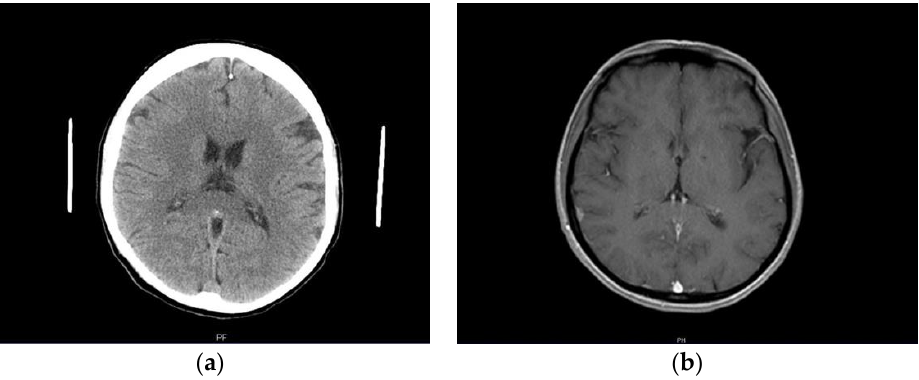
Figure 1. ( a ) Normal brain image — CT examination in native phase; ( b ) contrast-enhanced T1- weighted axial MR cross-section indicating a small right parietal meningioma (arrow).